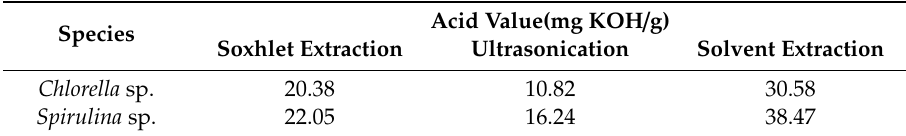
Table 2. Comparison study for the acid value of crude microalgae oil from three di ff erent methods of extraction.